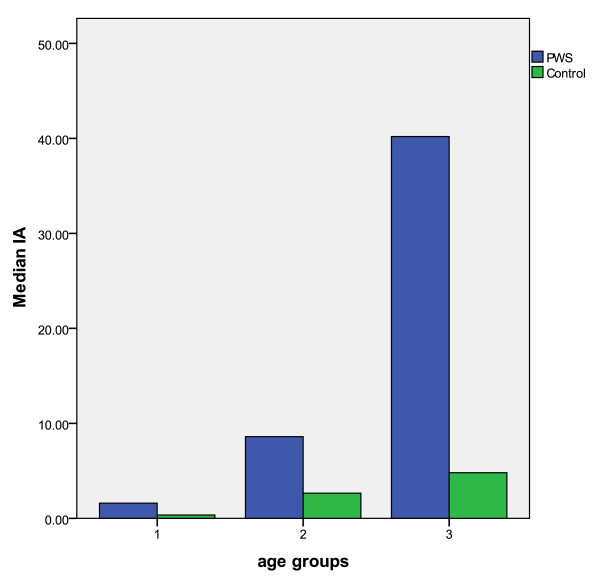
Tooth wear presented as median IAfor individuals in PWS- and control-group divided in three equally large age groups. Age groups (mean age, range years): 1; 9.8 (6.1-13.6) (n = 32), 2; 20.2 (13.7-25.4) (n = 34), 3; 31.5 (25.5-42.5) (n = 32).